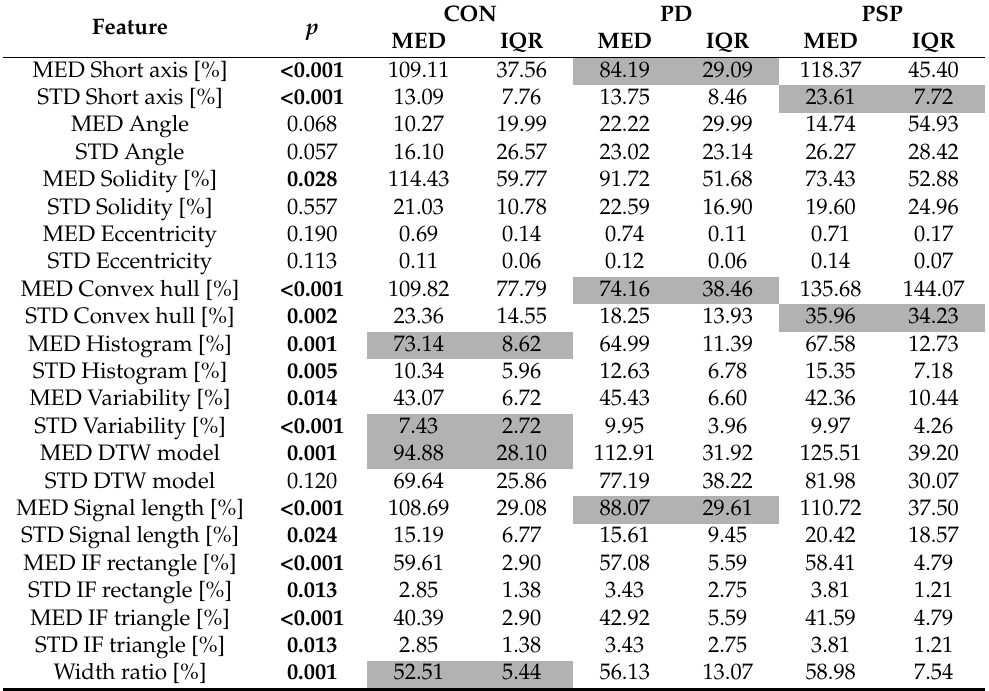
Table A4. Results of the Kruskal–Wallis ANOVA for triangles. Statistically significant values in bold ( p < 0.05). Groups with mean ranks significantly different from others are marked in gray. MED